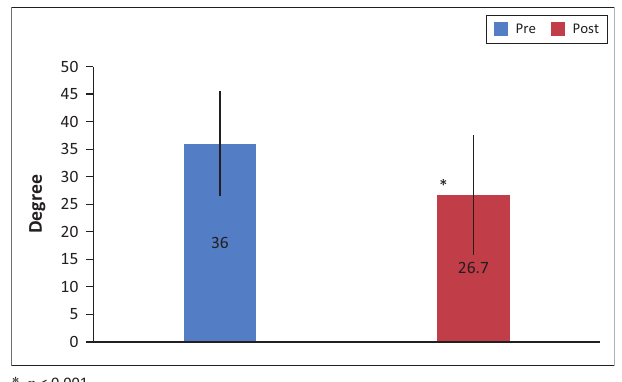
FIGURE 4: Mean knee extension range of motion (in degrees) ± standard deviation pre- and post-intervention in the group that received neurodynamic technique following passive stretching.